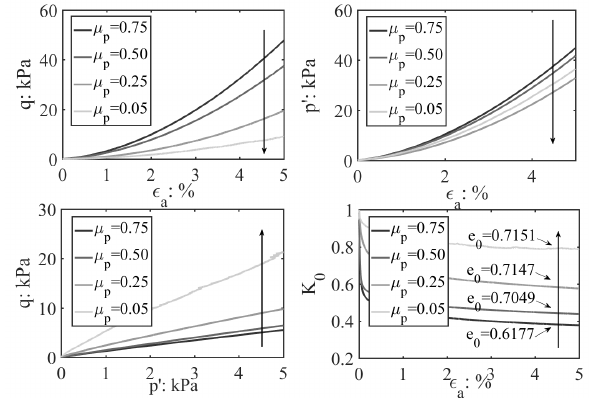
Figure 2. Dependency of macro-scale responses on interparticle friction for the RM samples that were compressed from p (cid:48) 100 kPa .